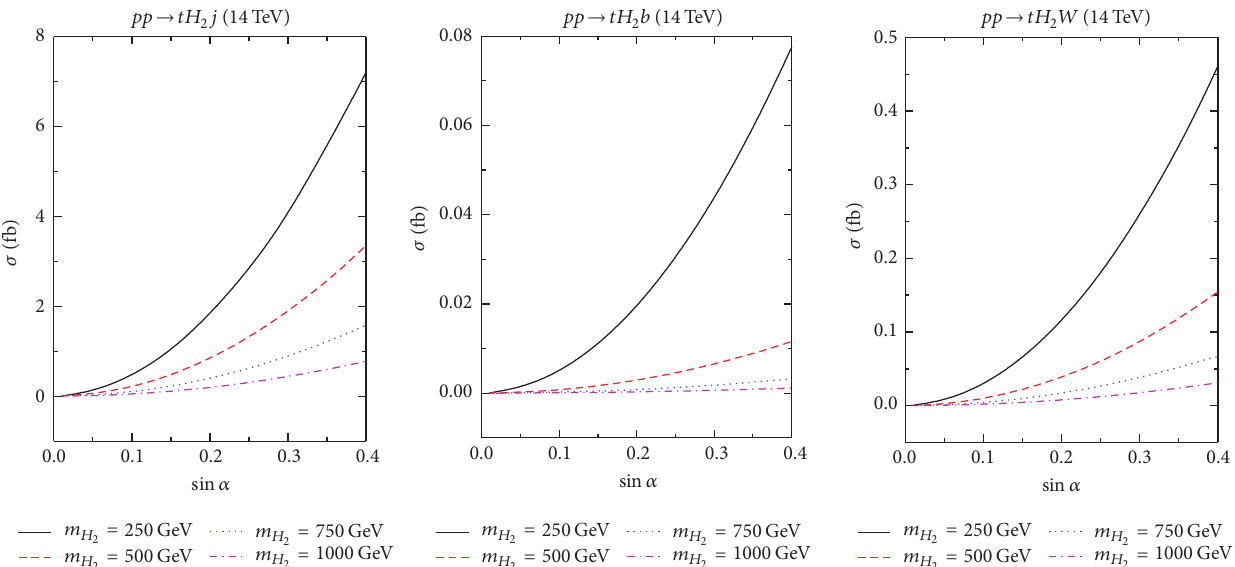
Figure 6: The production cross sections 𝜎 𝑡𝐻